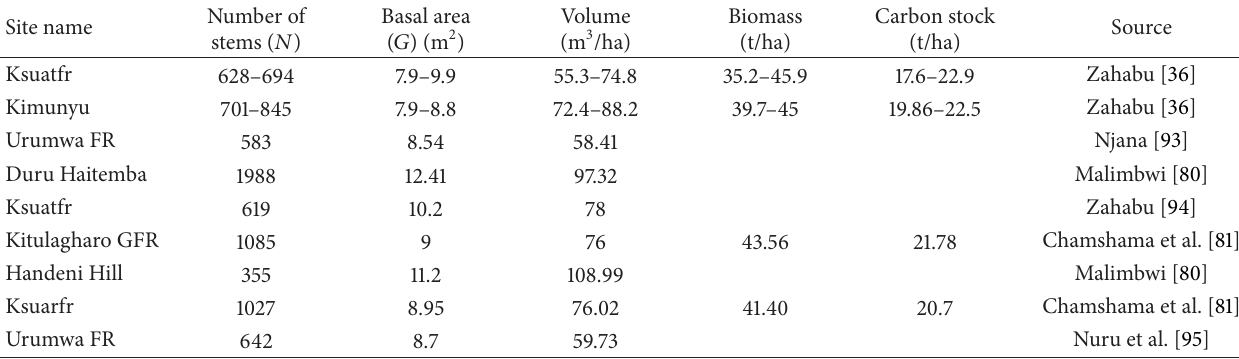
Table 7: Miombo woodland parameters describing biomass as studied in different